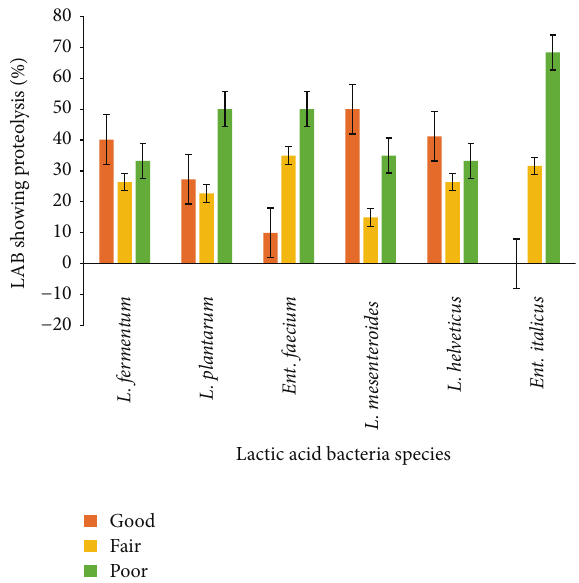
Figure 2: Pattern of proteolytic activities of predominant LAB isolated from Nunu . Good => 100–150 𝜇 g tyrosine/mL, fair => 50– 100 𝜇 g tyrosine/mL, and Poor = 0–50 𝜇 g tyrosine/mL.